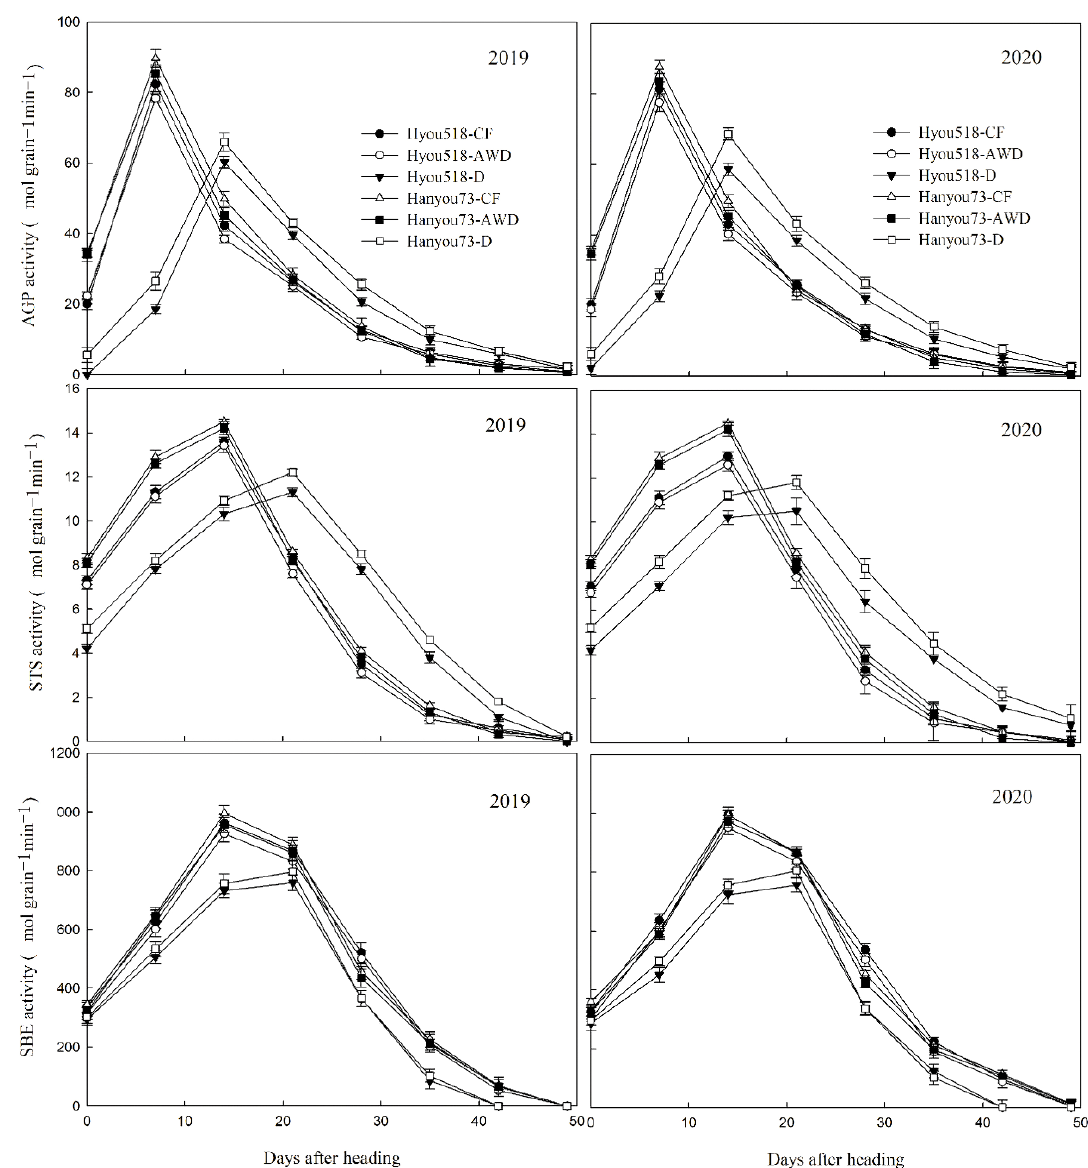
Figure 2. ADP-glucose pyrophosphorylase (AGP), soluble starch synthase (SSS), and starch branching enzyme (SBE) activities under various irrigation treatments. CF, AWD, and D represent continuously flooded, alternate wetting, and moderate soil drying irrigation, and dry cultivation, respectively. Vertical bars represent the ± standard errors of the mean ( n = 3) where these exceed the size of the symbol.